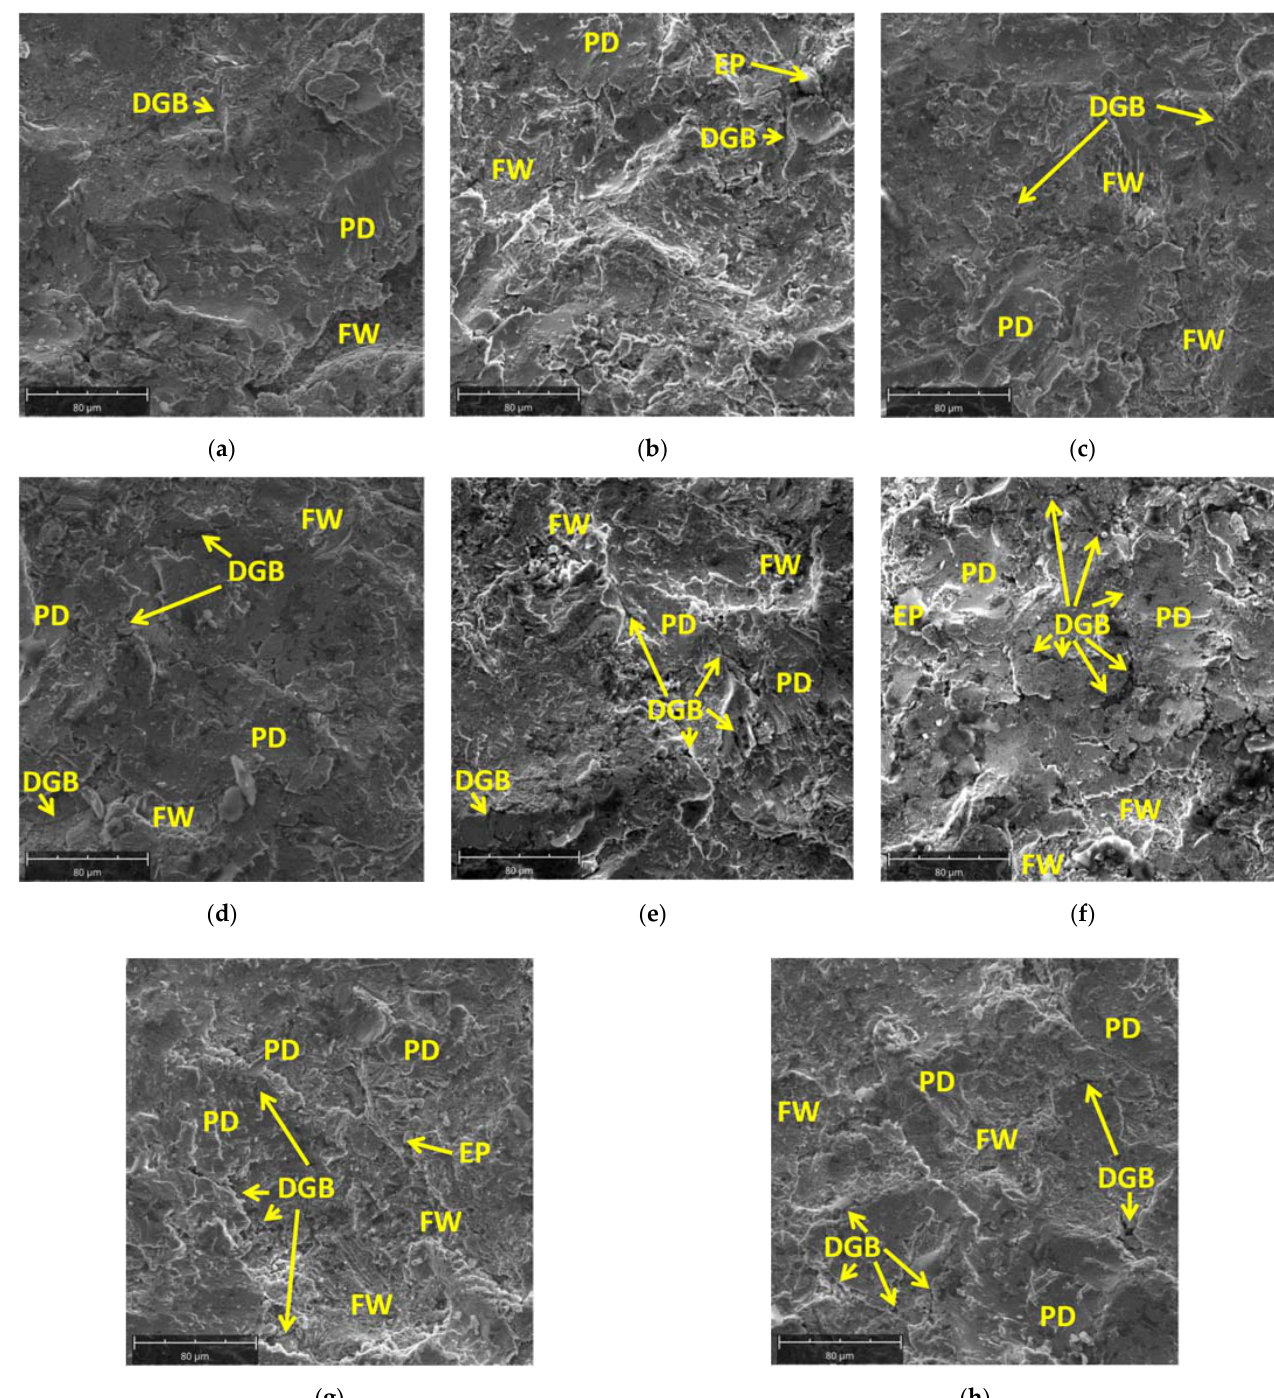
Figure 11. The surfaces of the investigated steel samples at a distance of 25 mm from the crater axis: ( a ) DC03, 30-second erosion test; ( b ) DC03 60-second erosion test; ( c ) DC04 60-second erosion test; ( d ) DC04 120-second erosion test; ( e ) DC05 30-second erosion test; ( f ) DC05 60-second erosion test; ( g ) DD14 60-second erosion test; ( h ) DD14 120-second erosion test. FW—fatigue wear; PD—plastic deformation; DGB—decohesion along the grain boundaries; EP—erosive particle stuck into the surface of the sheet.